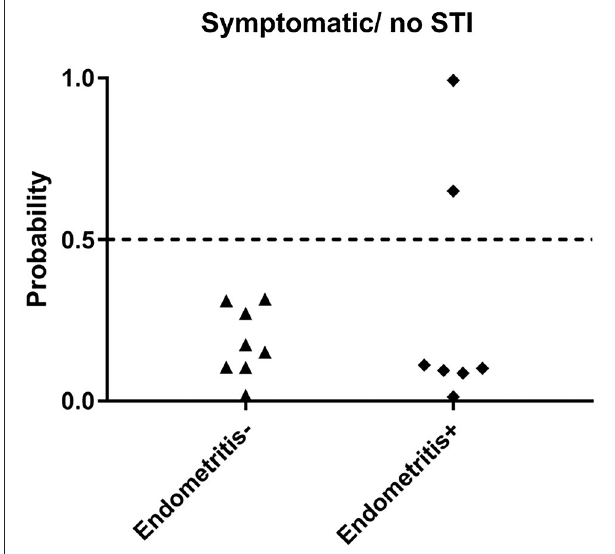
FIGURE 5 | Predicted probability using 21-gene signature and SVM of STI-induced endometritis in a dataset of women who were symptomatic but were uninfected. Subsets of patients within the dataset were positive and negative for histologic endometritis. Each dot represents one subject. The x-axis indicates two groups of women with pelvic pain without STI. One group has normal histology, the other group has chronic endometritis; y-axis indicates the predicted probability of STI-induced